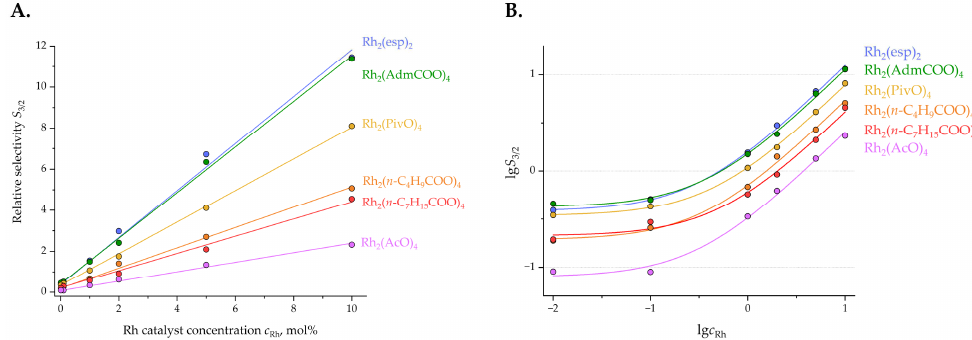
Figure 4. Chemoselectivity ( S 3/2 = c 3a / c 2a ) of 1a → 2a + 3a reaction performed with different catalysts and catalyst loadings: ( A ) in linear coordinates; and ( B ) in logarithmic coordinates.